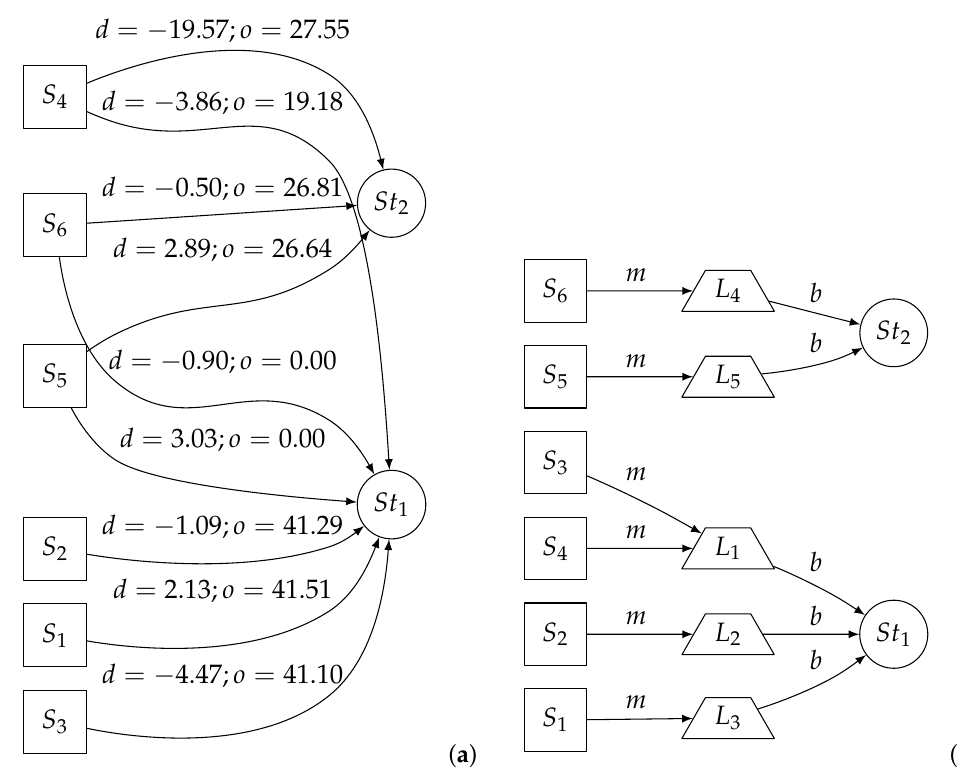
Figure 9. Graphs modelling the situation under consideration in Example 1; for clarity, node attributes are not shown: ( a ) ways and sensors after applying the spatial analysis procedure; all relationships (edges) are of the proximity type; ( b ) final assignment of sensors to lanes and